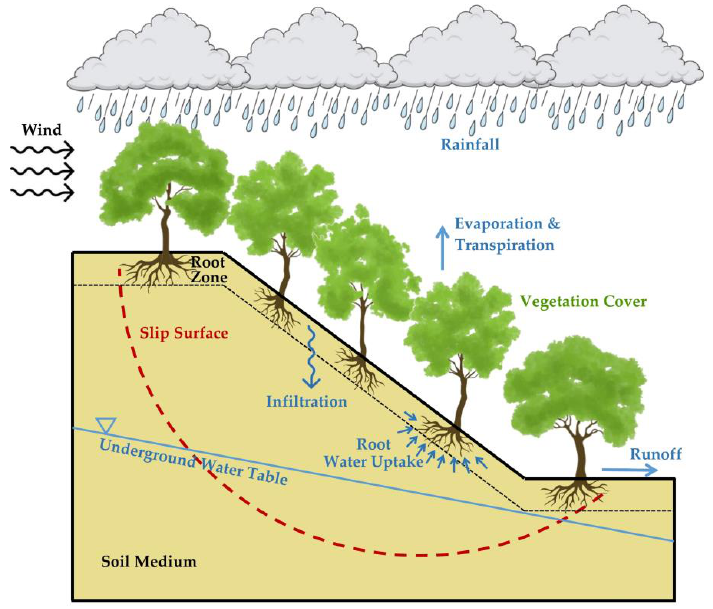
Figure 1. Schematic of vegetated slope stability analysis.